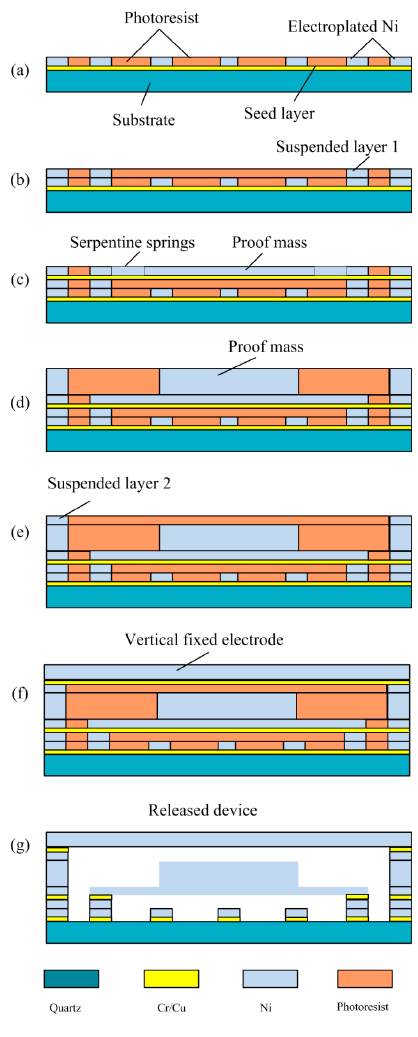
Figure 13. Main fabrication process sketch of the vertically-driven inertial microswitch.